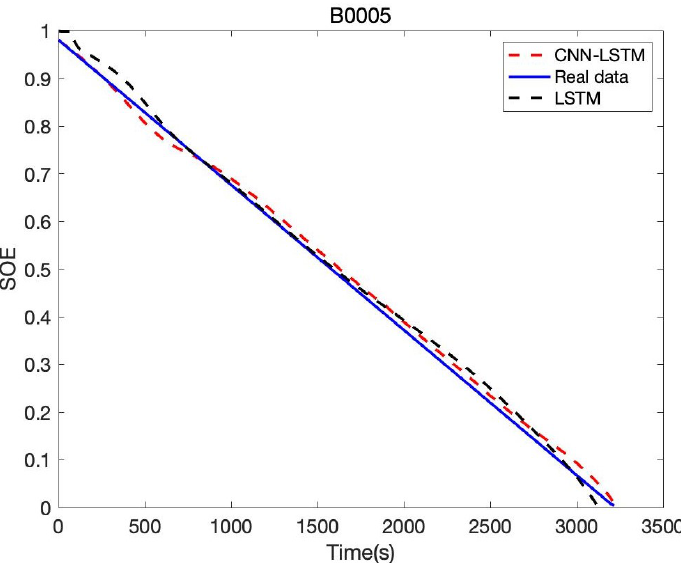
Figure 17. Battery SOE prediction result of B0005.